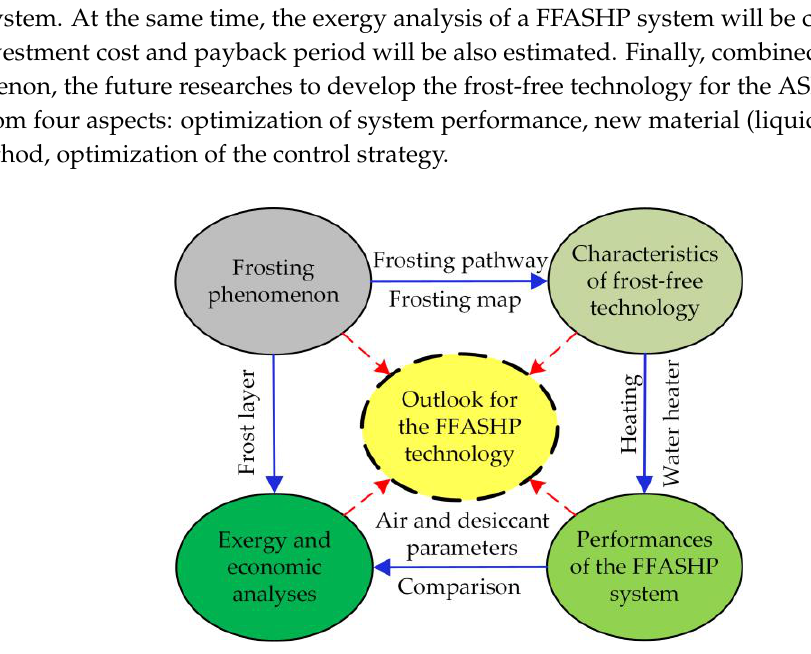
Figure 1. Roadmap of the present paper.